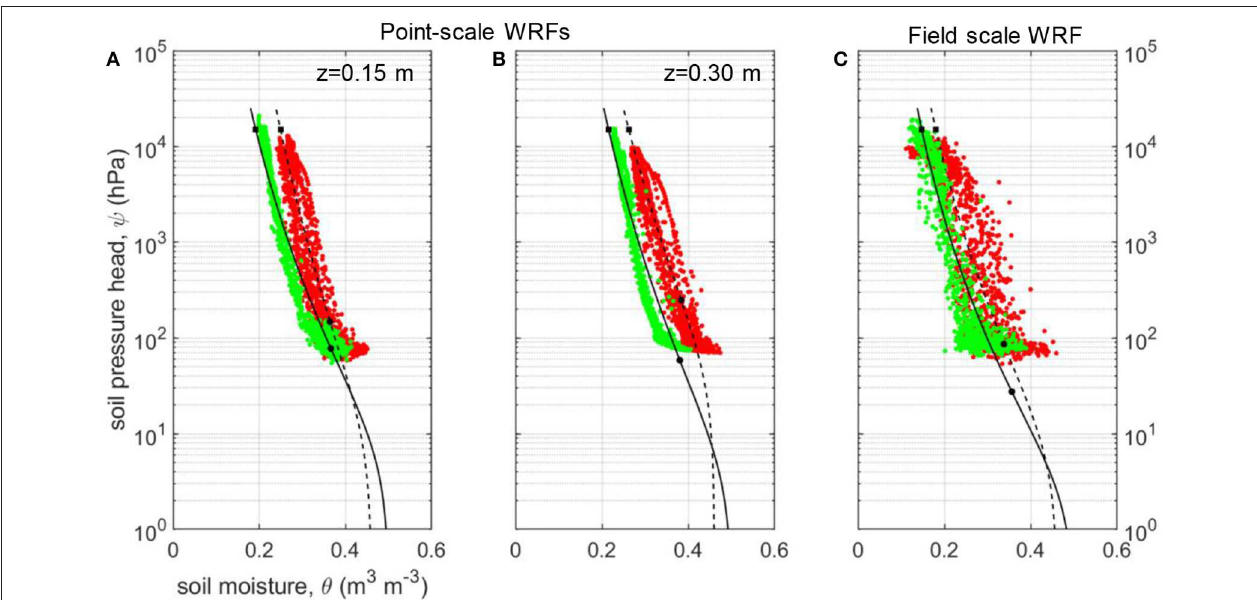
FIGURE 7 | Soil-water retention functions obtained by relating daily values of (A) SoilNet data pairs at z CRNP-based soil moisture ( θ CRNP,j ) and spatial-mean SoilNet-based soil matric potential (absolute value | ψ j |) at MFC2 (red circles) and GOR1 (green circles). Dashed black (MFC2) and solid black (GOR1) lines represent the soil-water retention curves fitted using van Genuchten’s parametric relation. Black circles and black squares denote the θ FC and θ WP values at the conditions of “field capacity” and “permanent wilting,” respectively.